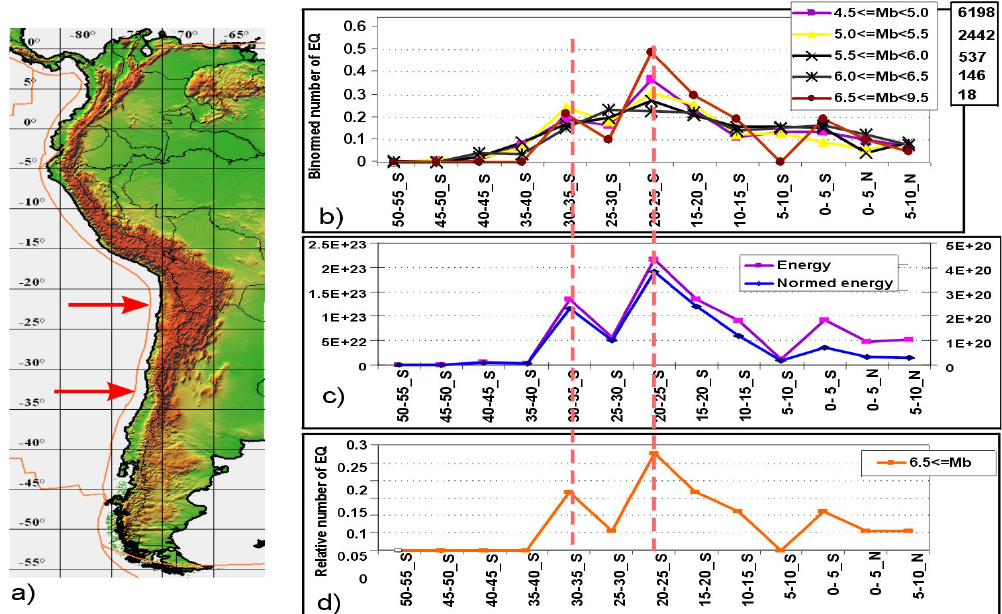
Fig. 5. (a) is the map of the South America with lithosphere plate boundaries (orange line). (b) is presented the binormed latitudinal